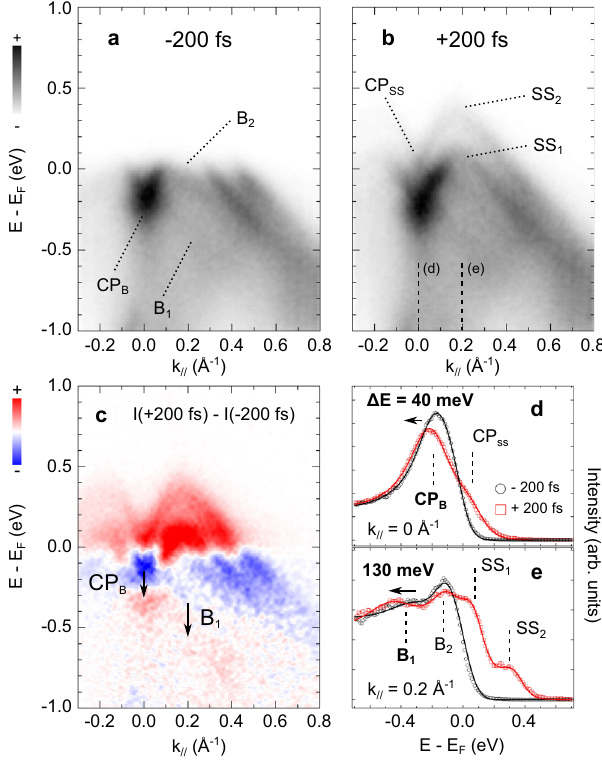
Fig. 2 | Out-of-equilibrium tr-ARPES measurements. a tr-ARPES spectra of α - GeTe(111) recorded at pump-probe delays of a − 200 fs and b +200 fs. The data have been acquired along the (cid:1) K (cid:1) (cid:1) Γ (cid:1) (cid:1) K direction with an absorbed pump fl u- ence of 1mJ/cm 2 . c Difference plot between panels b and a . Red and blue colors correspond to an increase and a depletion of photoemission intensity, respec- tively. The two arrows highlight the transient shift of the crossing point of the bulk states at normal emission (CP B ) and the B 1 contribution. This shift is visible as a red/blue contrast on the difference map. Energy distribution curves (EDCs) at − 200 fs (black) and +200 fs (red) taken at d k =0 Å − 1 (normal emission) and e k =0.2 Å − 1 (off-normalemission):seeverticaldashedlinesinpanel b .Solidlines correspond to a fi t of the raw